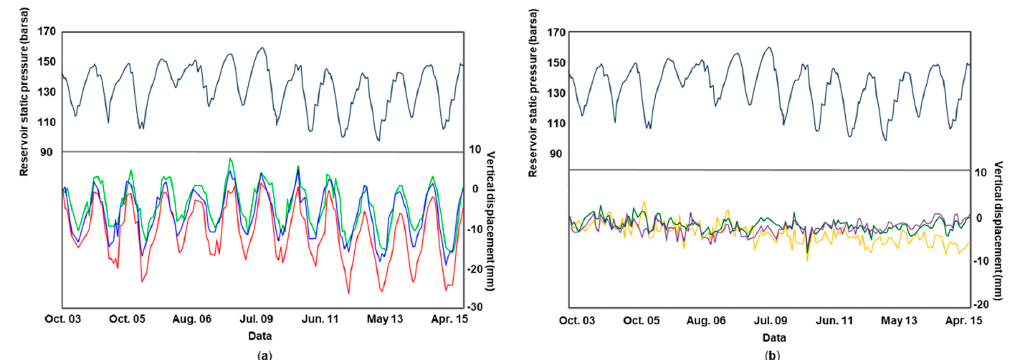
Figure 9. Comparison between reservoir average static pressure and measured vertical displacement ( a ) at control points overlying the reservoir and ( b ) at control points outside the UGS influence area.